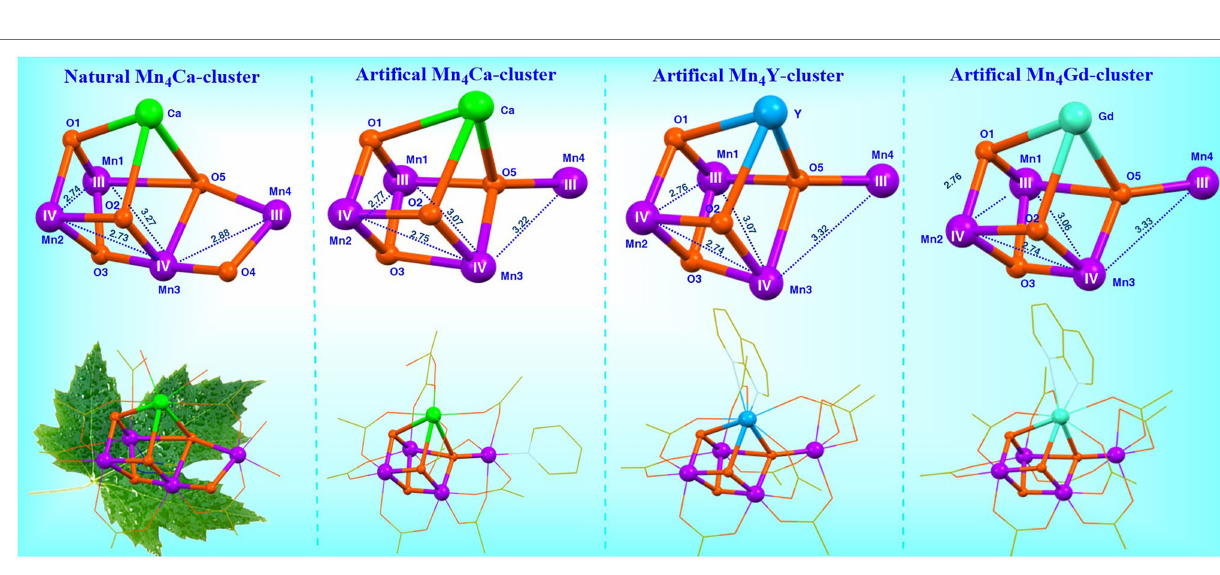
FIGURE 10 | Structural comparison of the OEC (Suga et al., 2015), Mn 4 CaO 4 -cluster ( 4 ) (Zhang et al., 2015), the Mn 4 YO 4 -cluster ( 10 ) and Mn 4 GdO 4 -cluster ( 11 ) (Yao et al., 2021). See Figure 5 for further